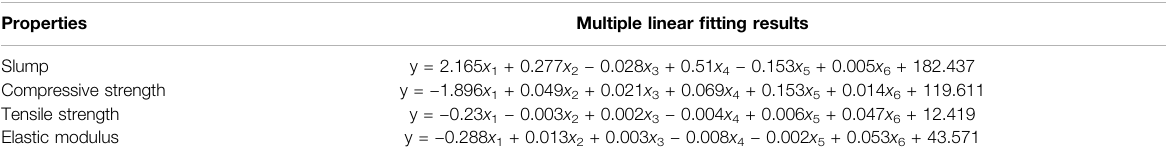
TABLE 5 | Multiple linear fi tting results between concrete properties and mix proportion.